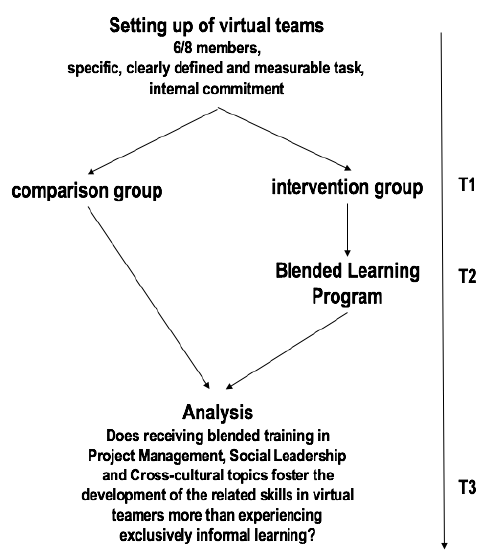
Figure 3. The next step: research design At T1, during the early stages of virtual team membership, we will measure team members’ project management, social leadership and cross-cultural skills as well as the team’s overall efficacy. At T2, the organization, assisted by the researchers, will provide specific training in project management, social leadership and cross-cultural topics to the virtual team leaders and members assigned to the virtual team intervention group. At T3, the measures administered at T1 will be repeated. We will then analyse whether gains in project management, social leadership and cross-cultural skills have influenced the efficacy of virtual teams, while controlling for the effects of baseline skills – as measured prior to delivery of the blended learning programme – and selected demographic variables (see Fig. 3). The study will be conducted with Nielsen TAM employees based in units that are still at the early stages of virtual team adoption, having only recently been acquired by